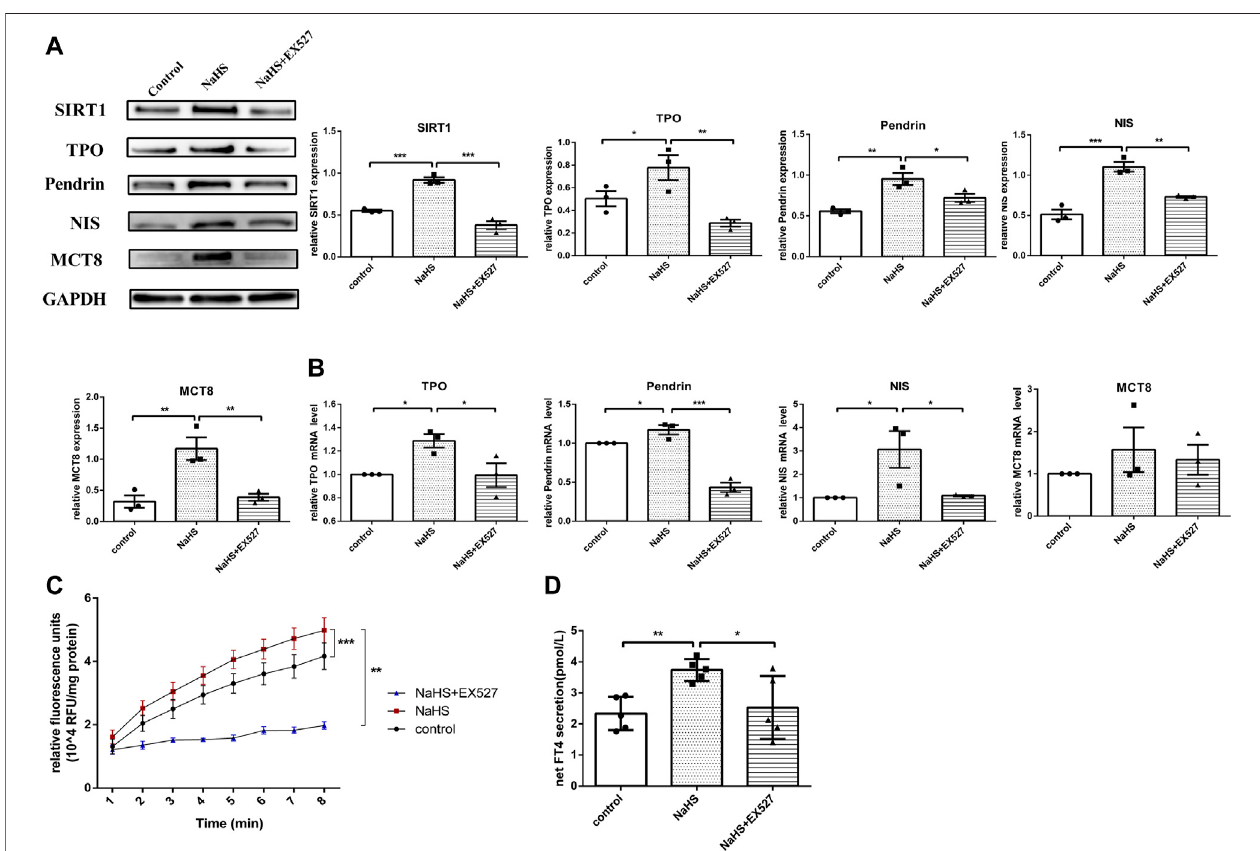
FIGURE 5 | The effect of H 2 S on thyroid hormone and related molecules in human primary thyrocytes. (A,B) SIRT1, TPO, Pendrin, NIS, MCT8 protein and mRNA expression in human primary thyrocytes stimulated with NaHS or NaHS + EX527 assessed by real-time PCR and Western blot. (C) Extracellular TPO activity of thyrocytes stimulated with NaHS or NaHS + EX527 for 48 h. Fluorescence was normalized to the corresponding protein amounts. (D) The FT4 level in supernatants of humanprimarythyrocytesstimulatedwithNaHSorNaHS+EX527for48 hinchemiluminescenceimmunoassay.NetFT4secretionmeantthatFT4valuesinblank culturemedium withoutthyrocytesweresubtractedfromFT4contentinthyrocyteculturesupernatant.* p < 0.05,** p < 0.01,*** p < 0.001.TPO:thyroidperoxidase,NIS: sodium/iodide symporter, MCT8: monocarboxylate transporter eight; NaHS, sodium hydrosul fi de. Data are expressed as the mean ± SEM, and all experiments were performed independently at least three